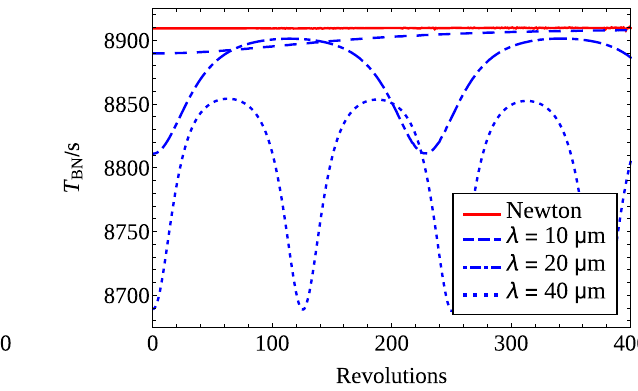
dotted lines, respectively). Right panel: α = 0 . 03, λ = 10 , 20 and 40 μ m (blue dashed, dot-dashed and dotted lines, respectively). In red, the constant Newtonian